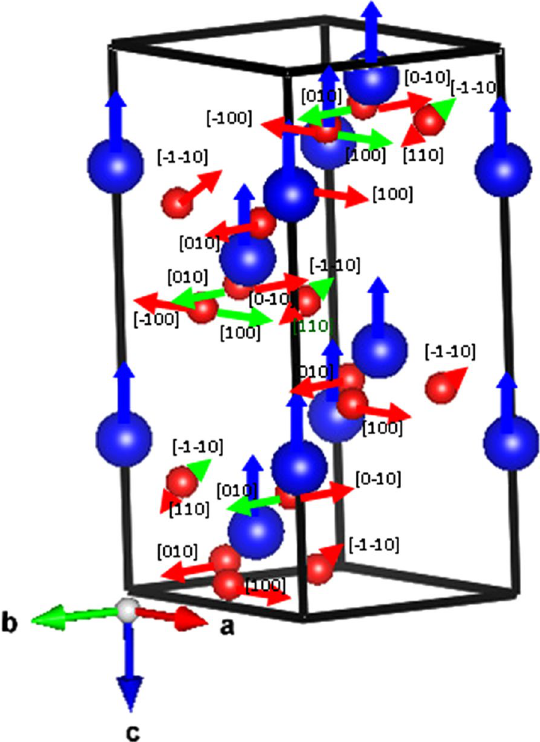
Figure 7. The Fe (blue) and O (red) ion displacements (the D 1 part) observed in bulk sample and ∼ 20 nm particles are shown. Fe ion displacements are shown by blue arrows while O ion displacements are shown by red and green arrows. The green arrows show the τ 2 mode of displacement while other arrows show the τ 1 mode. For clarity, Bi ions are not shown